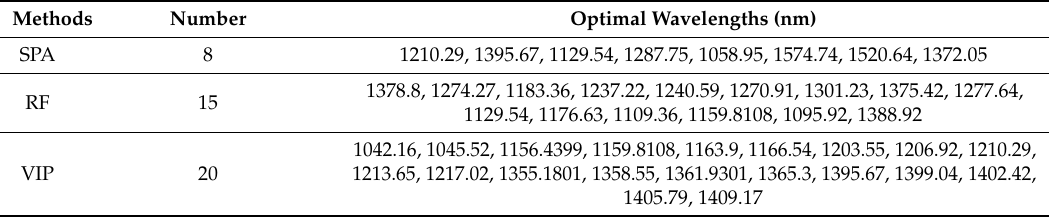
Table 3. The optimal wavelengths selected by SPA, RF and